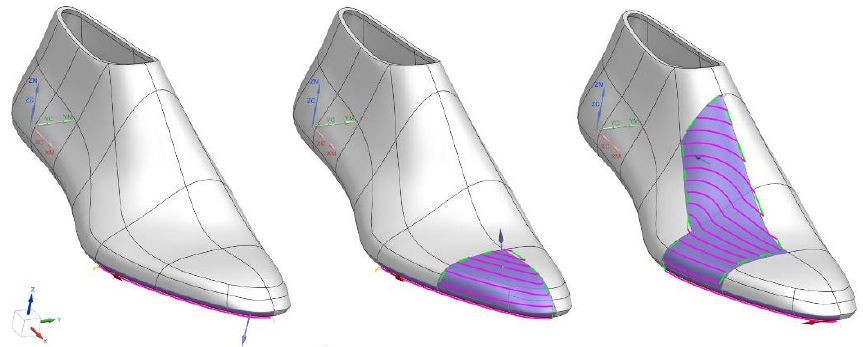
Figure 7. Tool path simulation on shoe last.